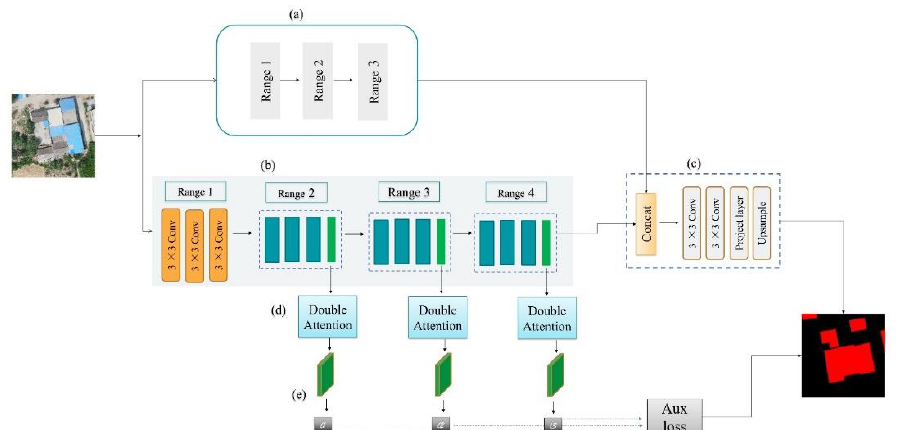
Figure 4. The architecture of the EDSANet model consists of two parts: the semantic encoding branch and the spatial information encoding branch. ( a ) Spatial information encoding module, ( b ) semantic encoding module, ( c ) feature fusion module, ( d ) dual attention module, and ( e ) attention feature refinement module.